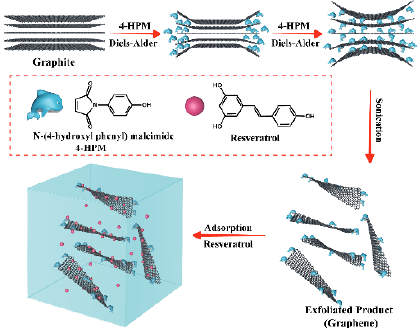
Scheme 1. Schematic of the one-pot Diels–Alder reaction strategy for the preparation of graphene and resveratrol adsorption on the resultant